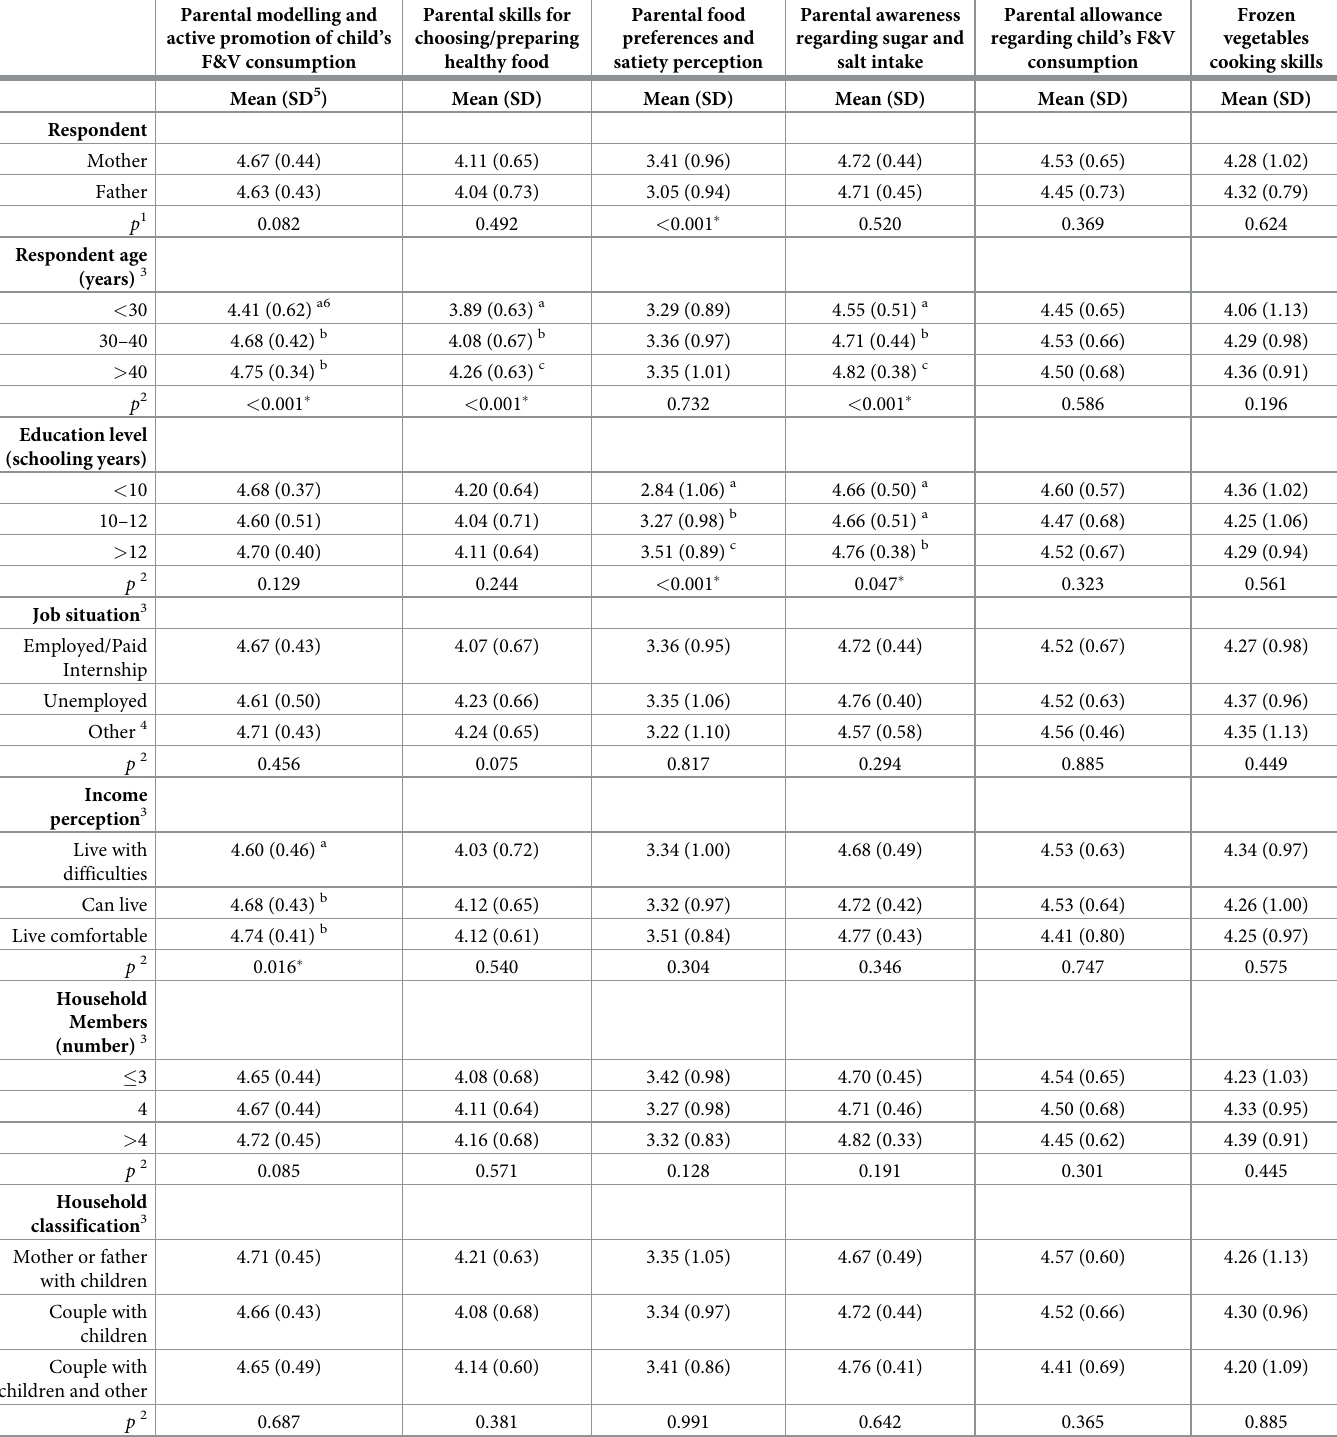
Table 3. Factors’ characterization according to socio-demographic characteristics and nutrition